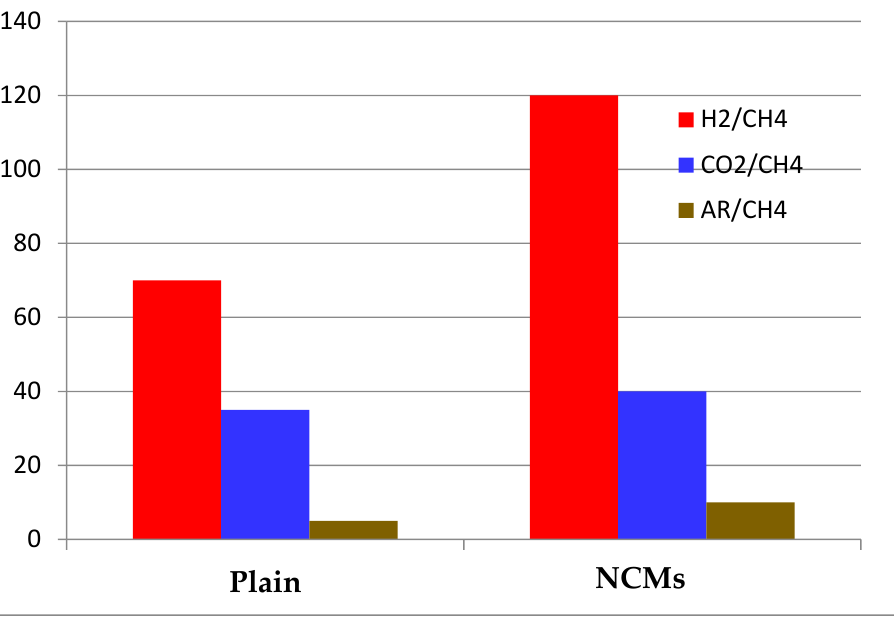
Figure 11. Na-Alg and NCMs ’ (ZIF-8) membrane gas selectivity under various gases.